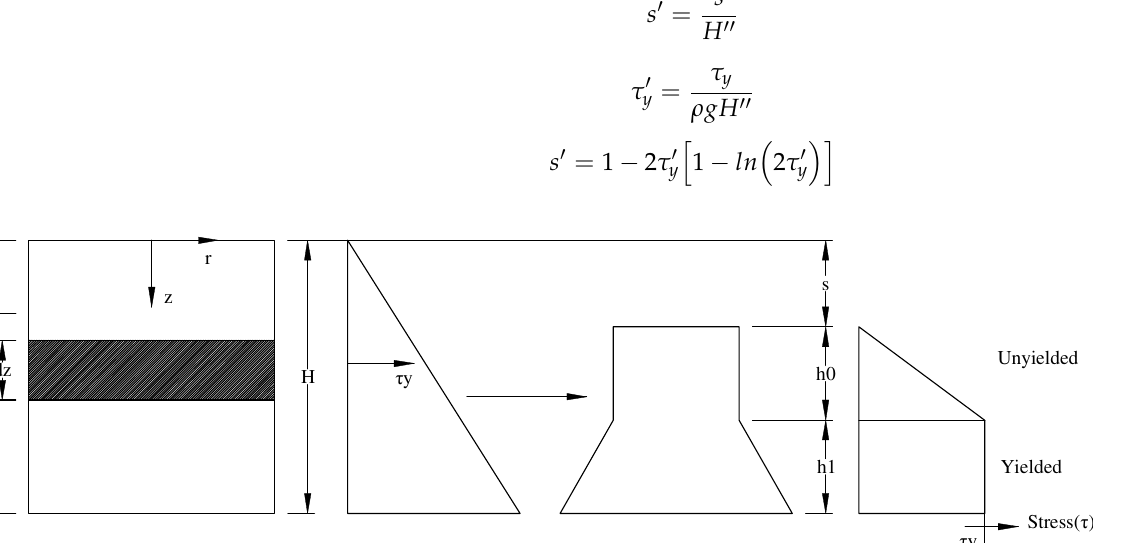
Figure 5. Schematic arrangement showing the initial and final stress distribution of the cylindrical mold slump test [25].